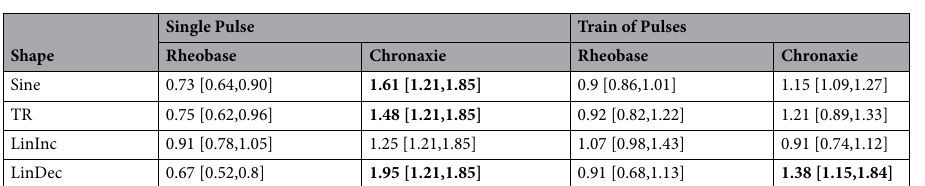
Table 1. Median and quartiles for normalized Rheobase current and Chronaxie time, with respect to Rect. Statistically significant differences are indicated in bold.